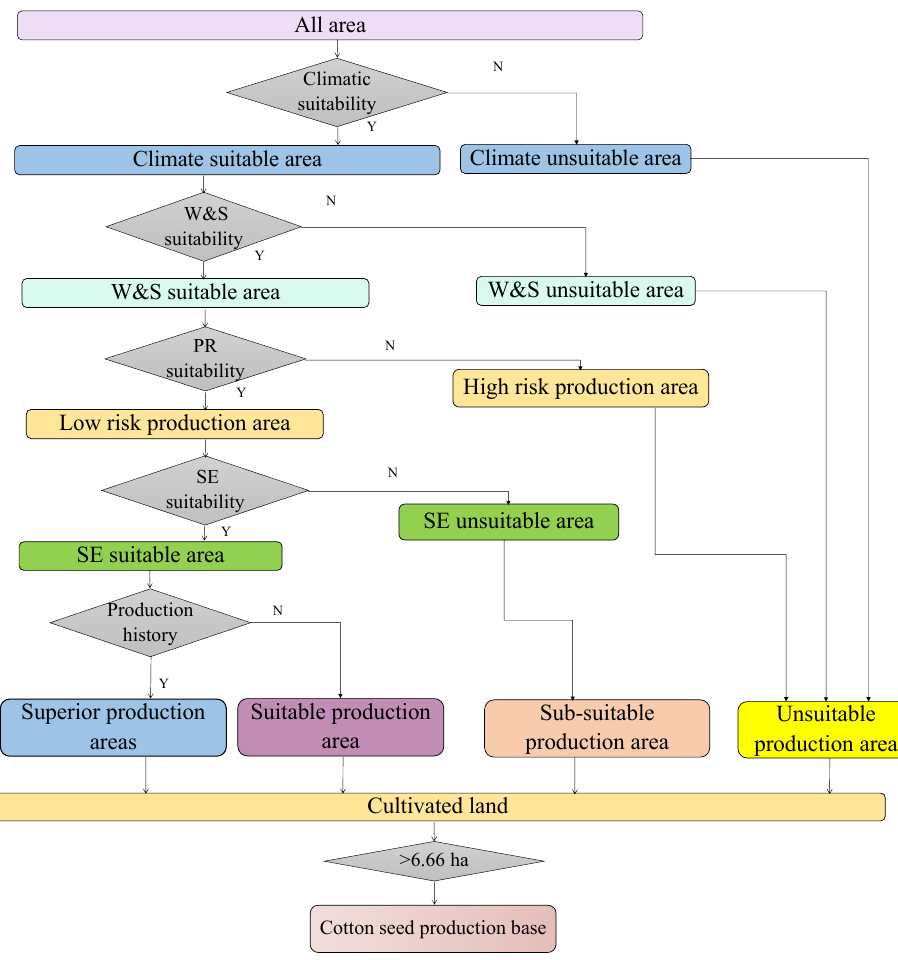
Figure 2. Diagram of methodological framework for the analysis of cotton seed production suitability based on hierarchical classification, where W&S, PR, and SE stand for water and soil, production risk, and social–economic, respectively. (Y indicates yes; N indicates no).